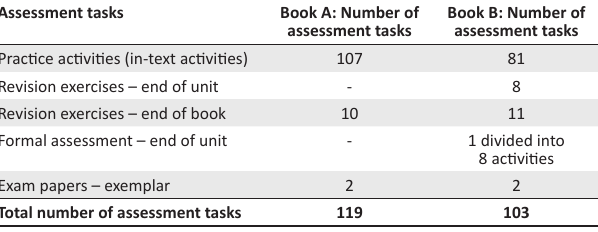
TABLE 4: Type and the number of assessment tasks. Assessment tasks Book A: Number of assessment tasks